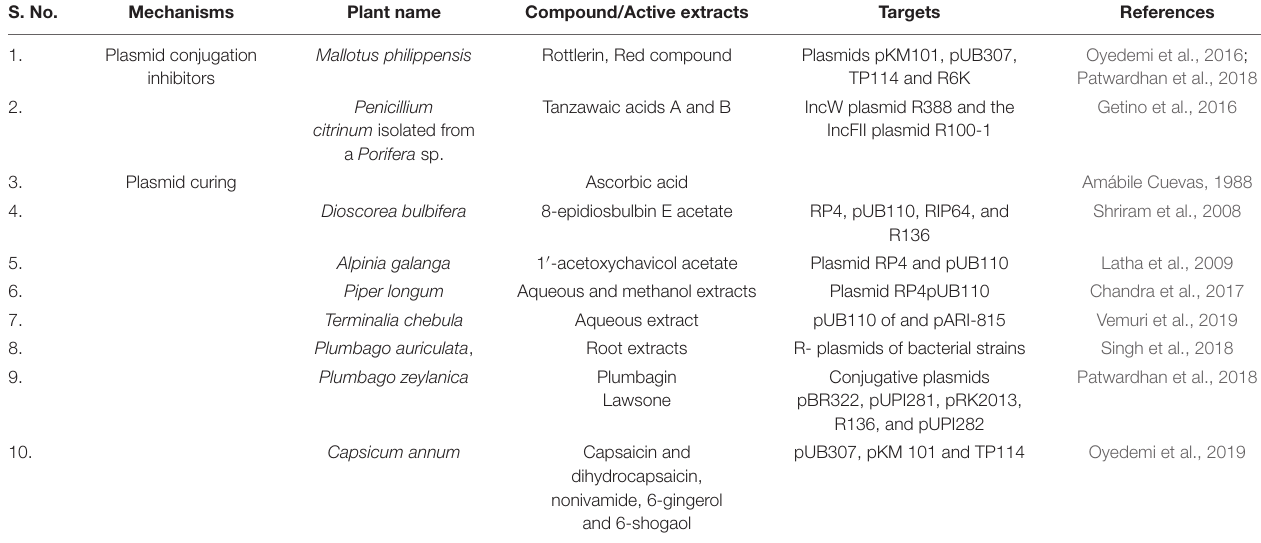
TABLE 1 | Plant derived compounds targeting the plasmids carrying AMR genes. S.